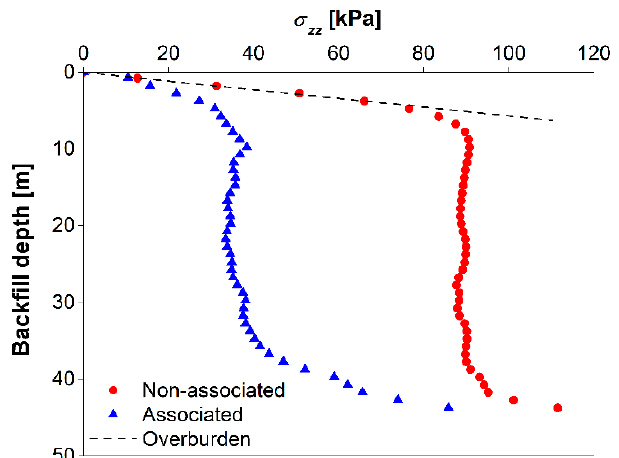
Figure 17. Stress distributions along the CL of the backfilled stope obtained from the numerical simulation conducted with the MSDP u -EPP model by considering the non-associated ( ξ = 0.01) and associated ( ξ = 1) flow rules for ( a ) vertical stress σ zz and ( b ) horizontal stress σ xx.